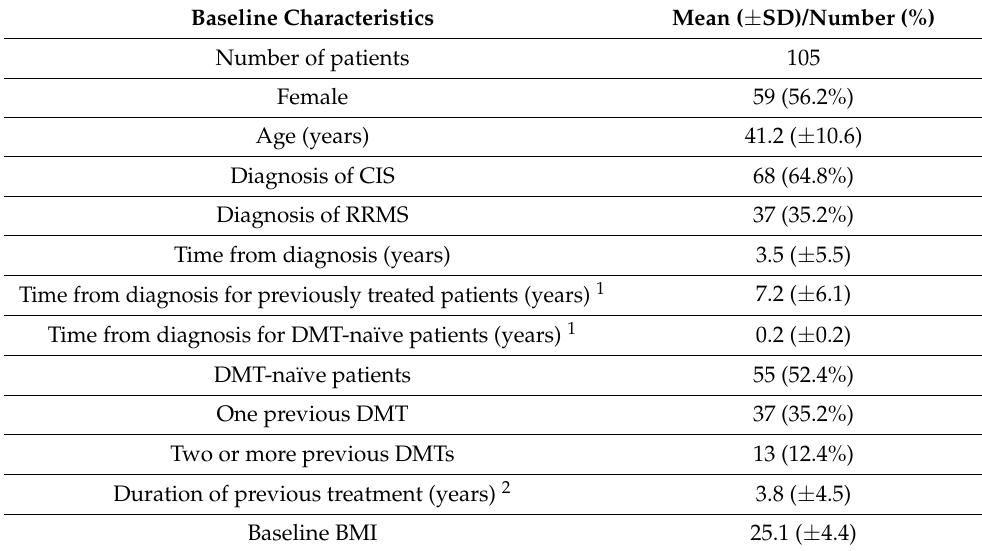
Figure 1. Patient flow according to the STROBE statement. Of the 114 patients enrolled, 9 (7.9%) were excluded from the analysis. The remaining 105 patients represent the per protocol (PP) population presented in the results. For the analysis of the primary objective, only patients who had available data on the included variables (i.e., all questionnaires completed) after 9 months of treatment were included (N = 82). Table 1. Baseline characteristics of the cohort before teriflunomide initiation.